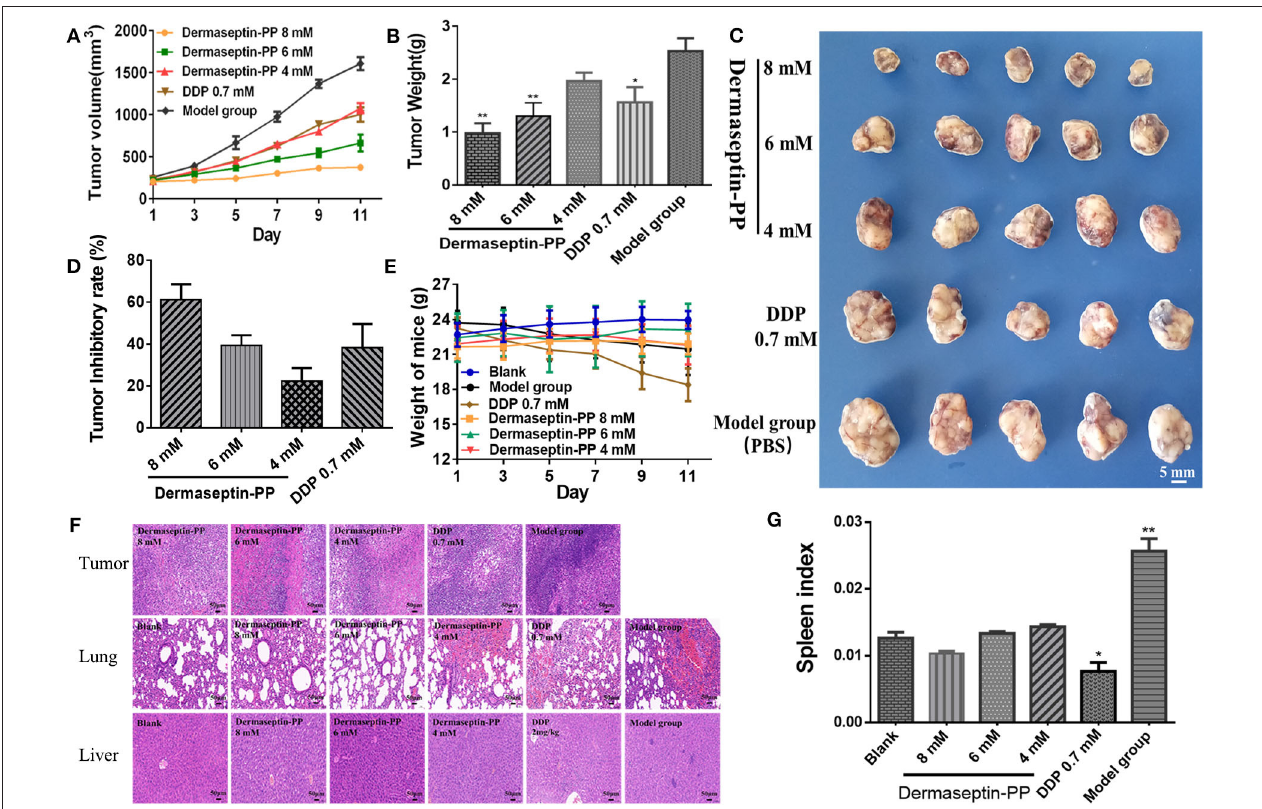
FIGURE 5 | (A) Tumor volume of all administration groups measured every 2 days with SEMs shown as error bars around the mean of each data point. (B) The quantification tumor weight of the excised tumor of all administration groups. Data was analyzed with unpaired Student’s t -test using GraphPad Prism 5 software. ** P < 0.01, * P < 0.05 vs. model group (PBS). (C) The images of the excised tumor of all administration groups. (D) Tumor inhibitory rate of Dermaseptin-PP and DDP. The data represent means ± SEM (standard error of the mean). (E) Every 2-day weight changes of mice in each group during the experiment with SEMs shown as error bars around the mean of each data point. (F) Representative images of HE staining ( × 200) of isolated tumor, lung and liver of different administration groups to evaluate the tissue histological conditions. (G) The calculated spleen index of mice in different groups. Data was analyzed with unpaired Student’s t -test